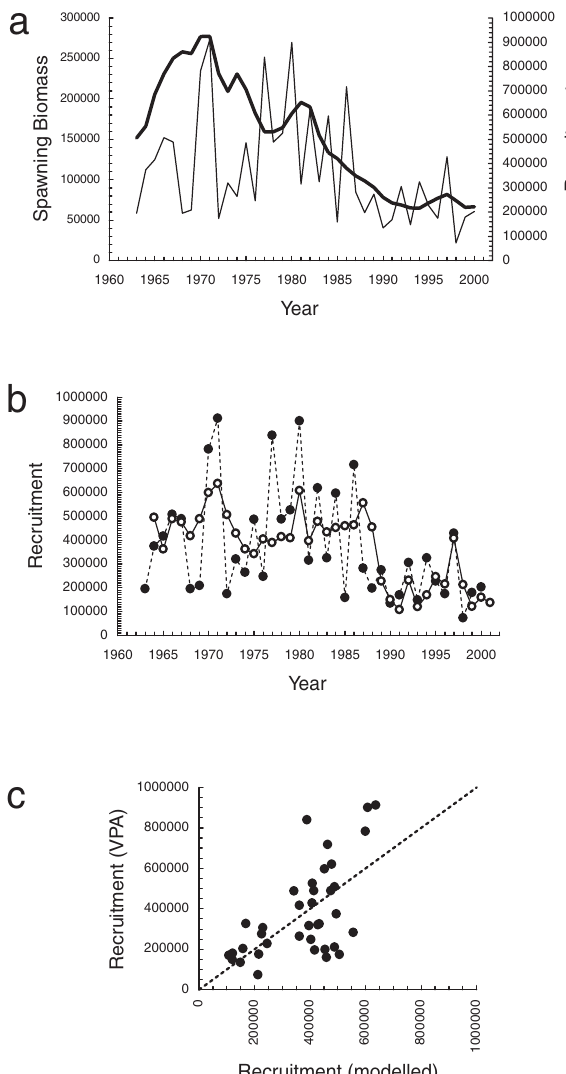
F IG . 2. – a. Recruitment (thin line, 1000s of recruits at age 1) and spawning stock biomass (heavy line, in tons) time series for North Sea cod from the latest ICES assessment WG (Anonymous, 2001) b. Recruitment (dotted line, closed circles) and the fit of the SSB- SST model (plain line, open circles) based on all data available in year 2000. c. VPA derived recruitment values against fitted recruitment values.